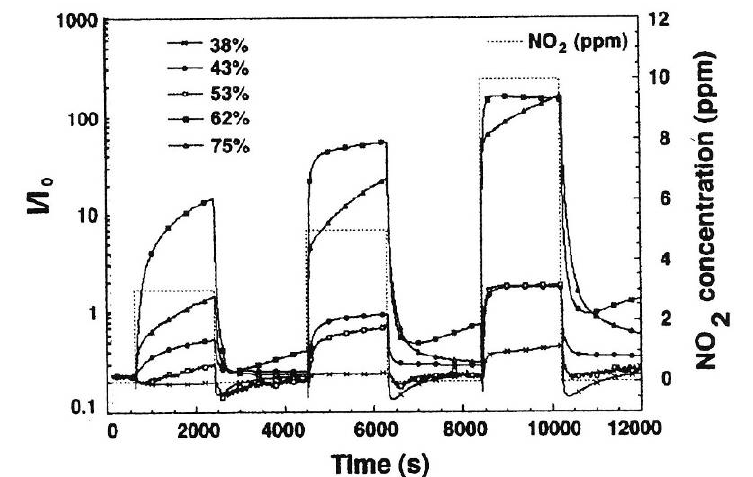
Figure 1. Dynamic response of mesoporous silicon samples of different porosity, varying (diagram taken from between 38% and 75% to NO 2